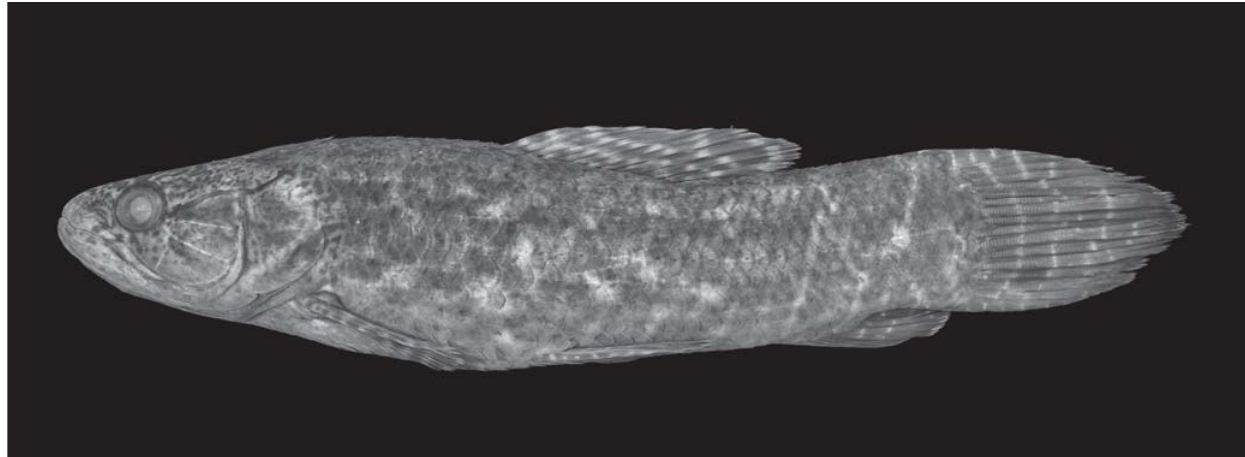
Fig. 5. Hoplias curupira , holotype, MZUSP 45582, 157.9 mm SL, rio Itacaiúnas, Caldeirão, Serra dos Carajás, Pará State,